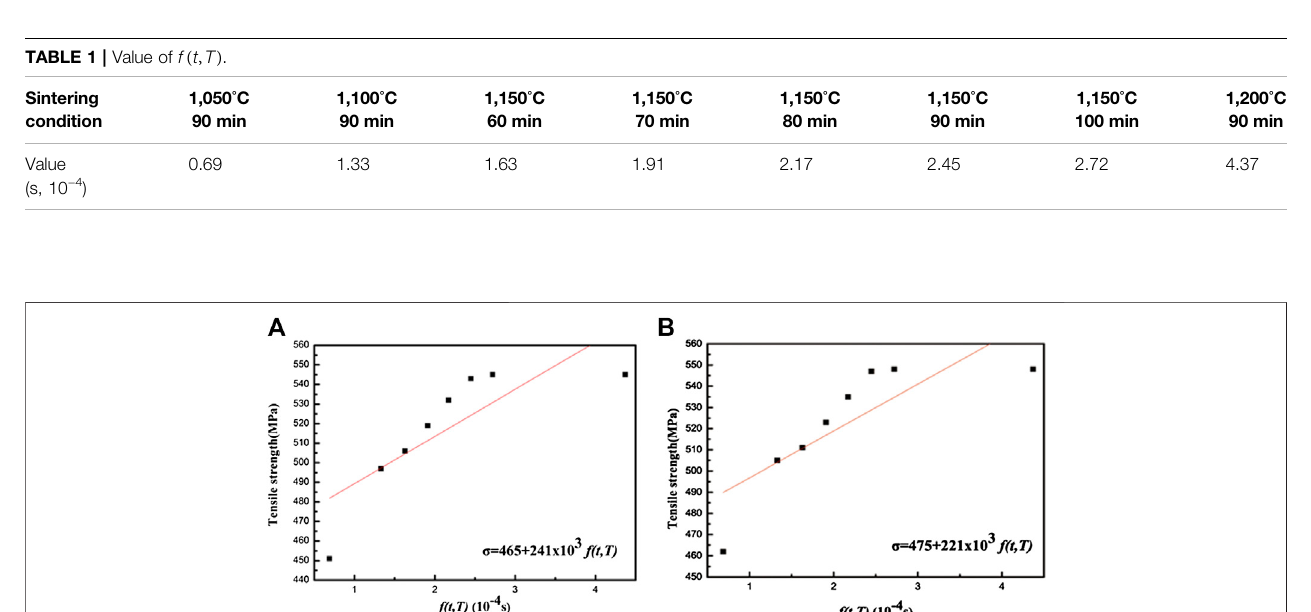
TABLE 1 | Value of f ( t , T ) .